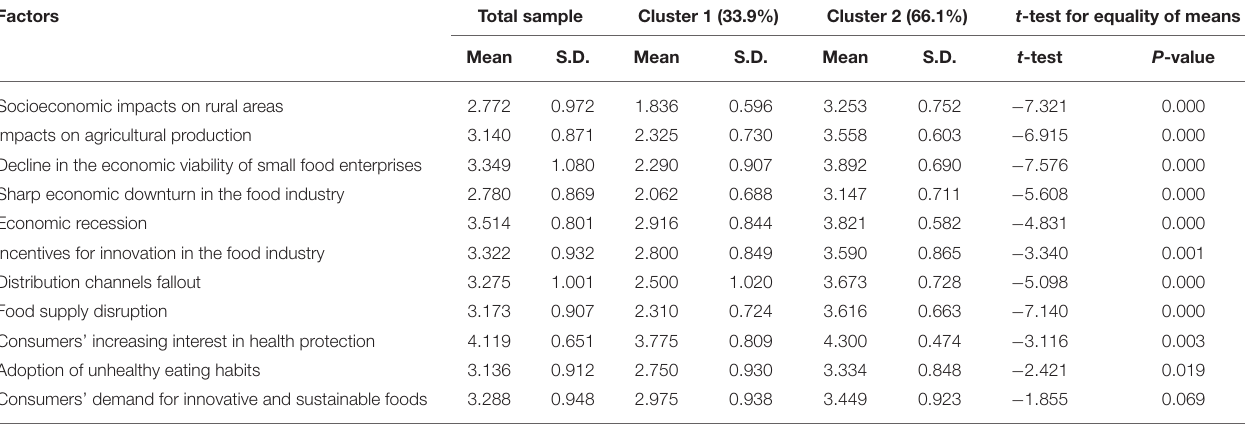
TABLE 10 | Cluster analysis results for experts’ attitudes toward COVID-19 consequences for food industry.